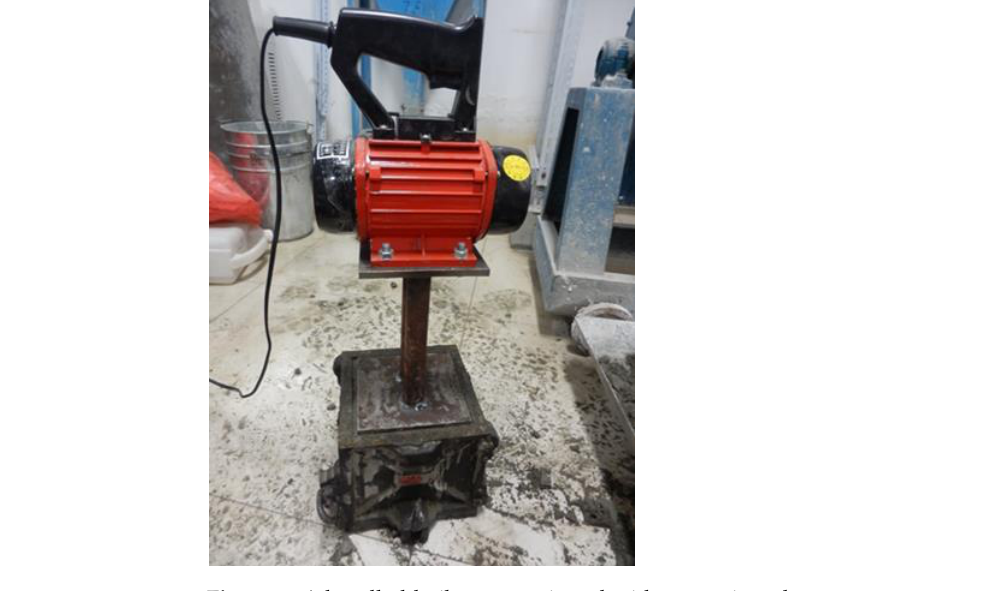
Figure 7. A handheld vibrator equipped with a pressing plate.